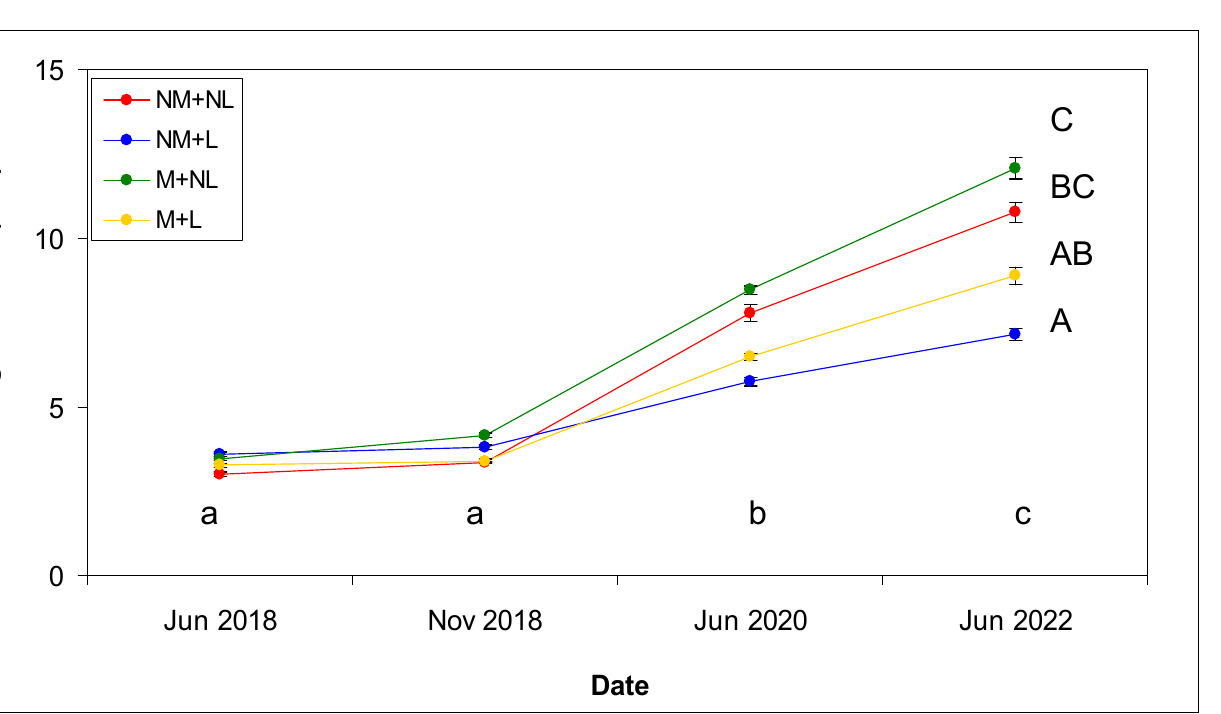
Figure 2. Variation of diameter of seedlings (mean ± standard deviation) of Pinus halepensis Mill. growing in plots subjected to four treatments in Sierra de Los Donceles forest (Liétor, Castilla La Mancha, Spain). Different lowercase and capital letters indicate significant differences among survey dates and treatments, respectively, according to the LSD test ( p < 0.05). Legend: M + L = Mulching + Logging; NM + L = No Mulching + Logging; NM + NL = No Mulching + No Logging; M + NL = Mulching + No Logging.